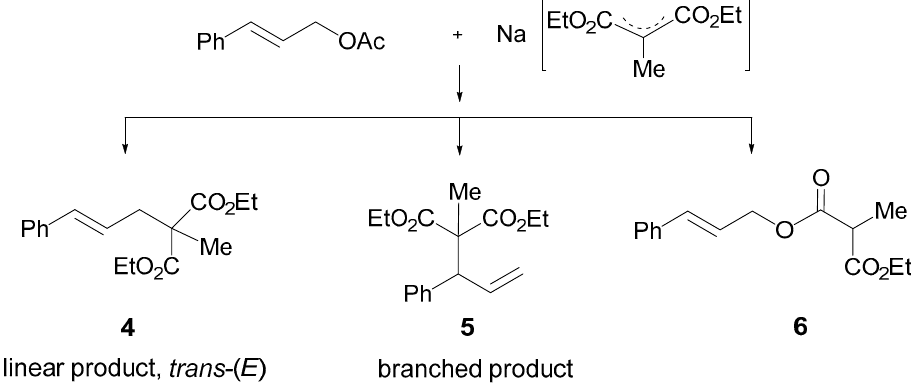
Table 2. Results of the catalytic allylic alkylation of cinnamyl acetate with sodium